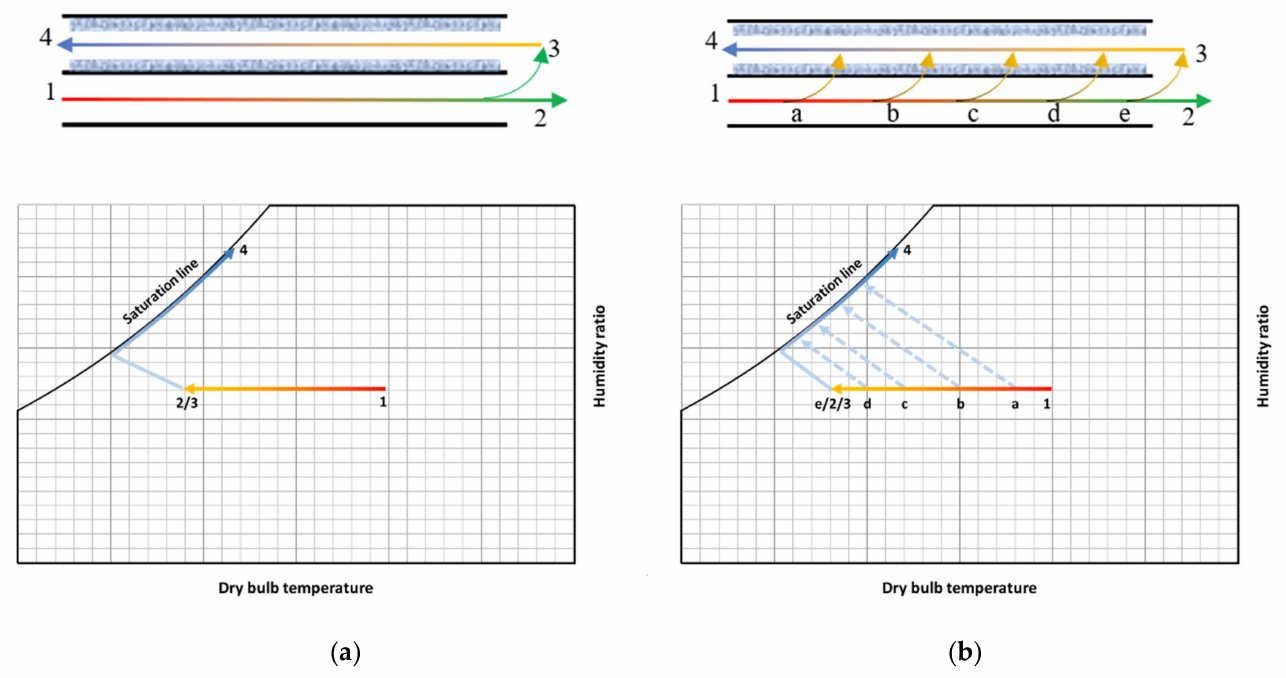
Figure 2. Working principles and psychrometric chart illustrations of ( a ) RIEC and ( b ) M-cycle